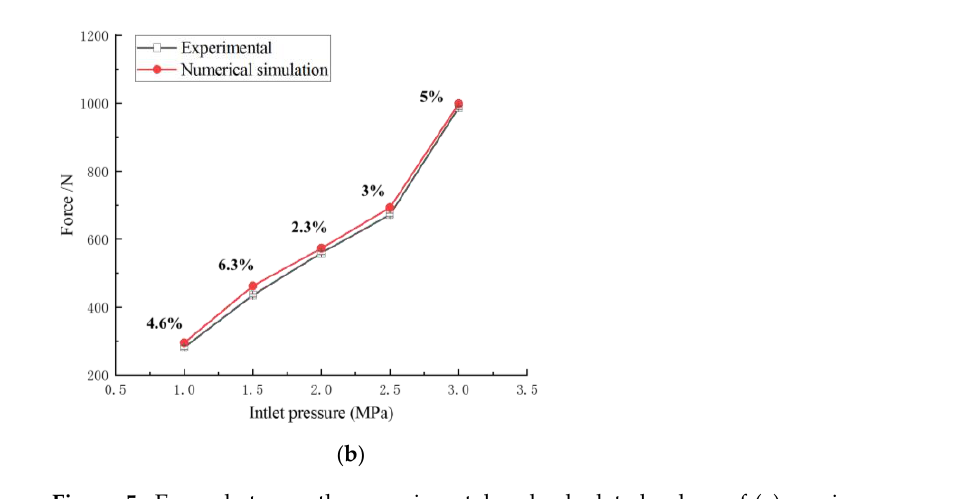
Figure 5. Errors between the experimental and calculated values of ( a ) maximum pressure and ( b ) force.